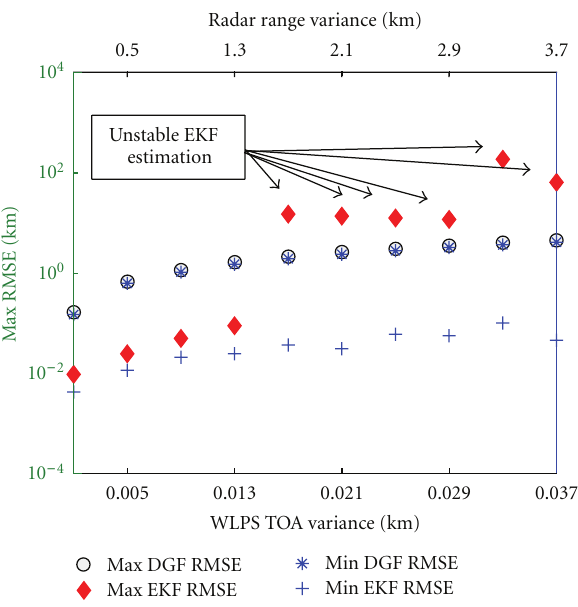
Figure 8: Minimum and maximum mean RMSE comparison bet- ween two filters with respect to measurement noise increment.